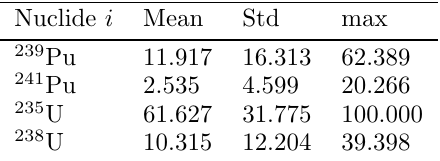
Table 3. Mean, Std and maximum values of the fractions f i for neutron production of some nuclides from the UGd dataset.